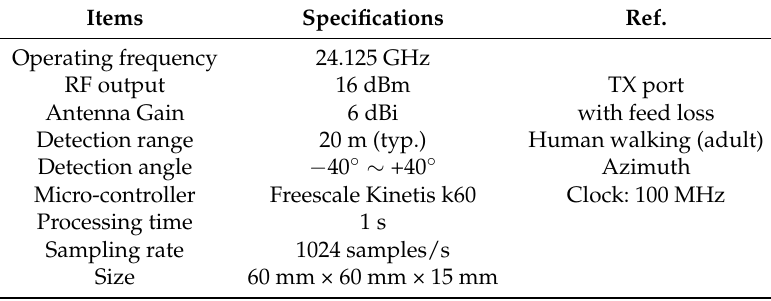
Table 1. The specifications of 24 GHz Doppler